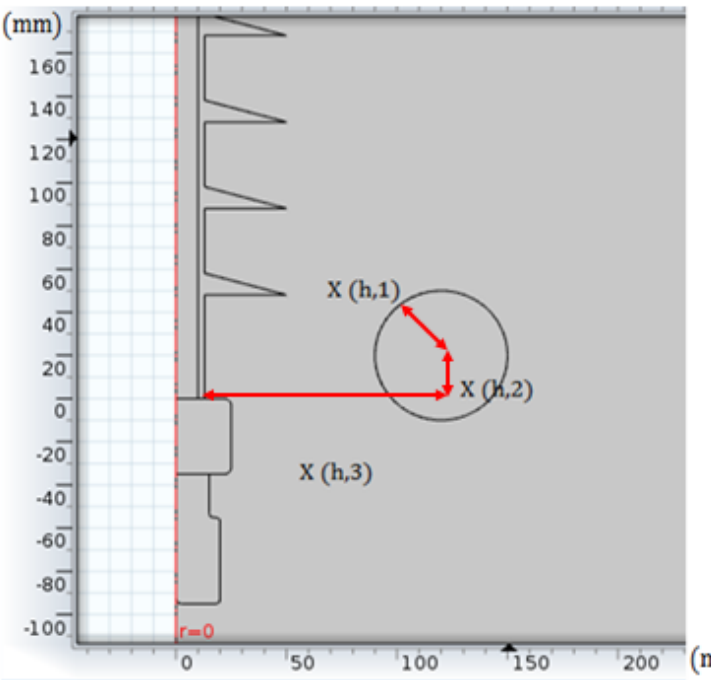
Figure 12. Optimised parameters of insulator and corona ring. Table 6. Upper and lower limits of each parameter for the algorithm.